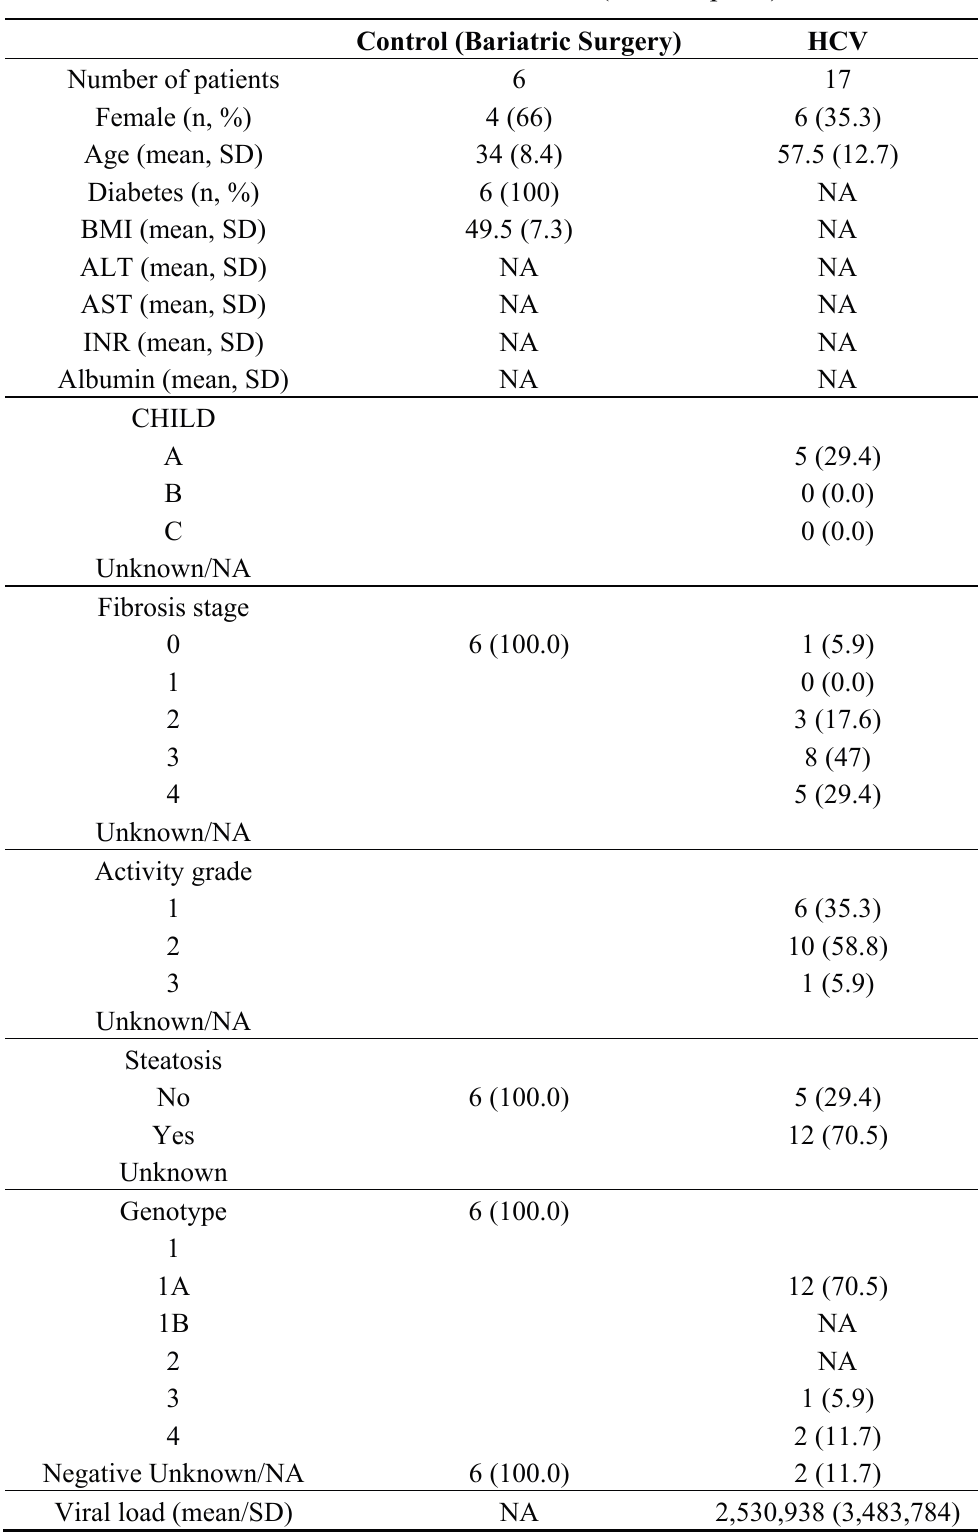
Table 3. Patients’ characteristics (liver